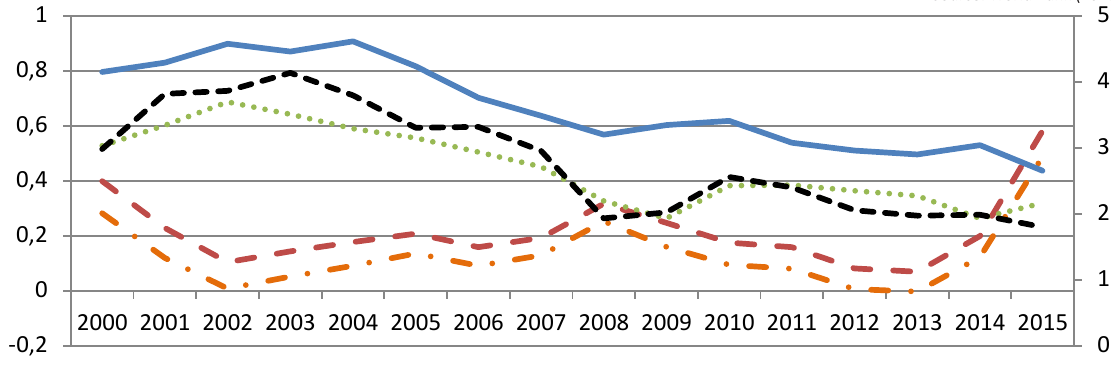
Figure 1. Graphical interpretation of the analysis of macroeconomic stability of Ukraine for the period 2000–2015 (own calculations based on data from)